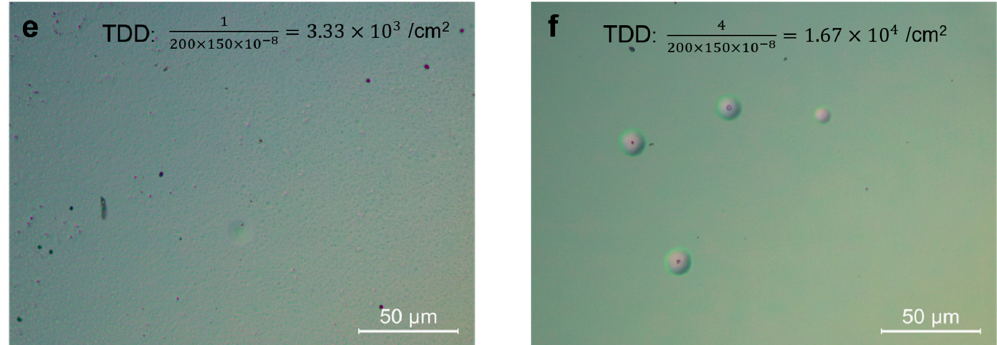
Figure 2. ( a ) XRD spectra of Si 0.5 Ge 0.5 and Ge films grown on Si (001); ( b ) The SAED and low-magnification TEM image of the Si 0.5 Ge 0.5 film grown on Si (001); ( c , d ) are AFM images of Si 0.5 Ge 0.5 and Ge films, respectively; ( e , f ) shows the typical etch pits distribution of the Si 1 − x Ge x thin films (x from 0.5 to 1), with TDD of 10 3 –10 4 /cm 2 level. The films were etched by Secco etchant. All films are 200 nm thick and grown at 200 °C.